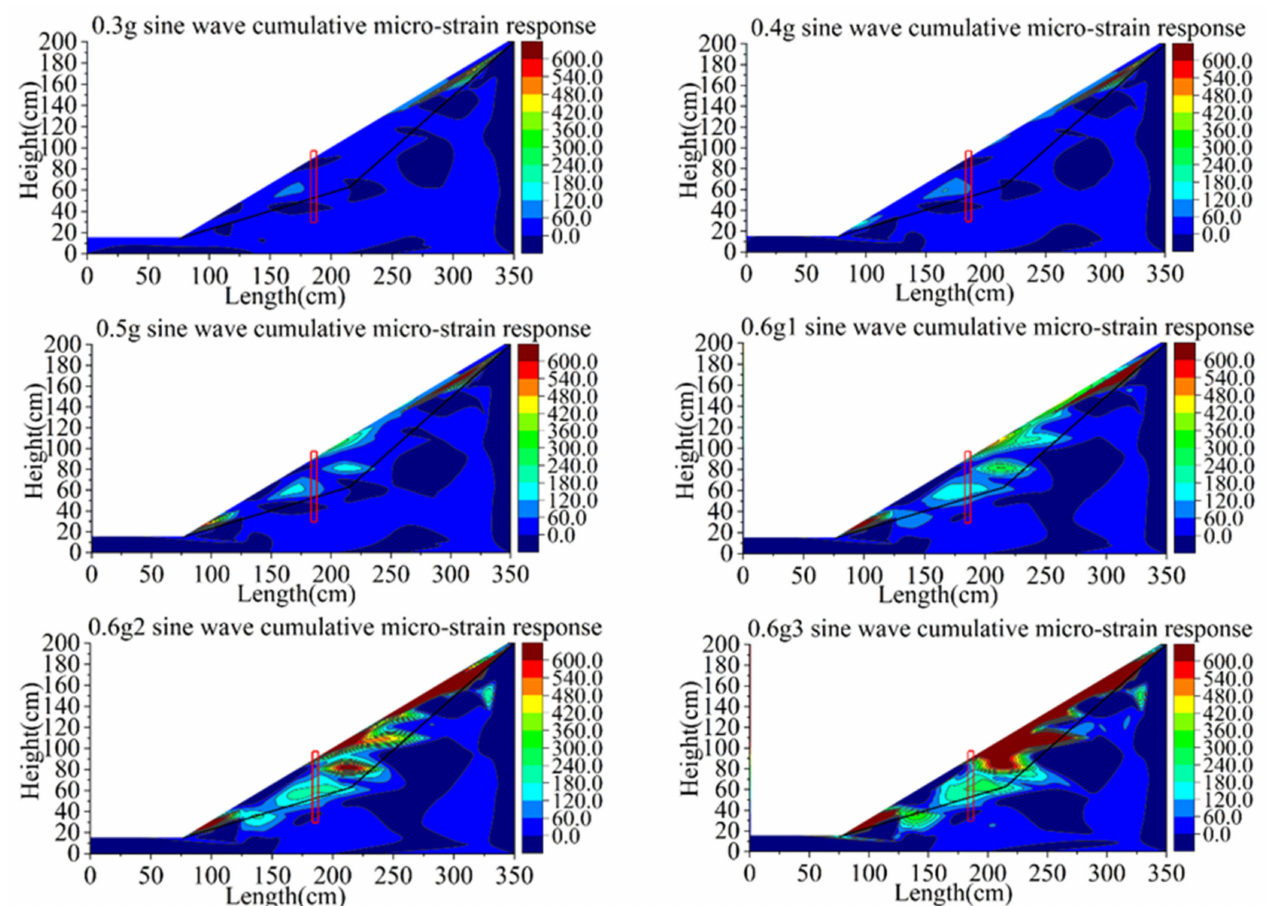
Figure 20. Contours of shear strain response of model C (unit: µε